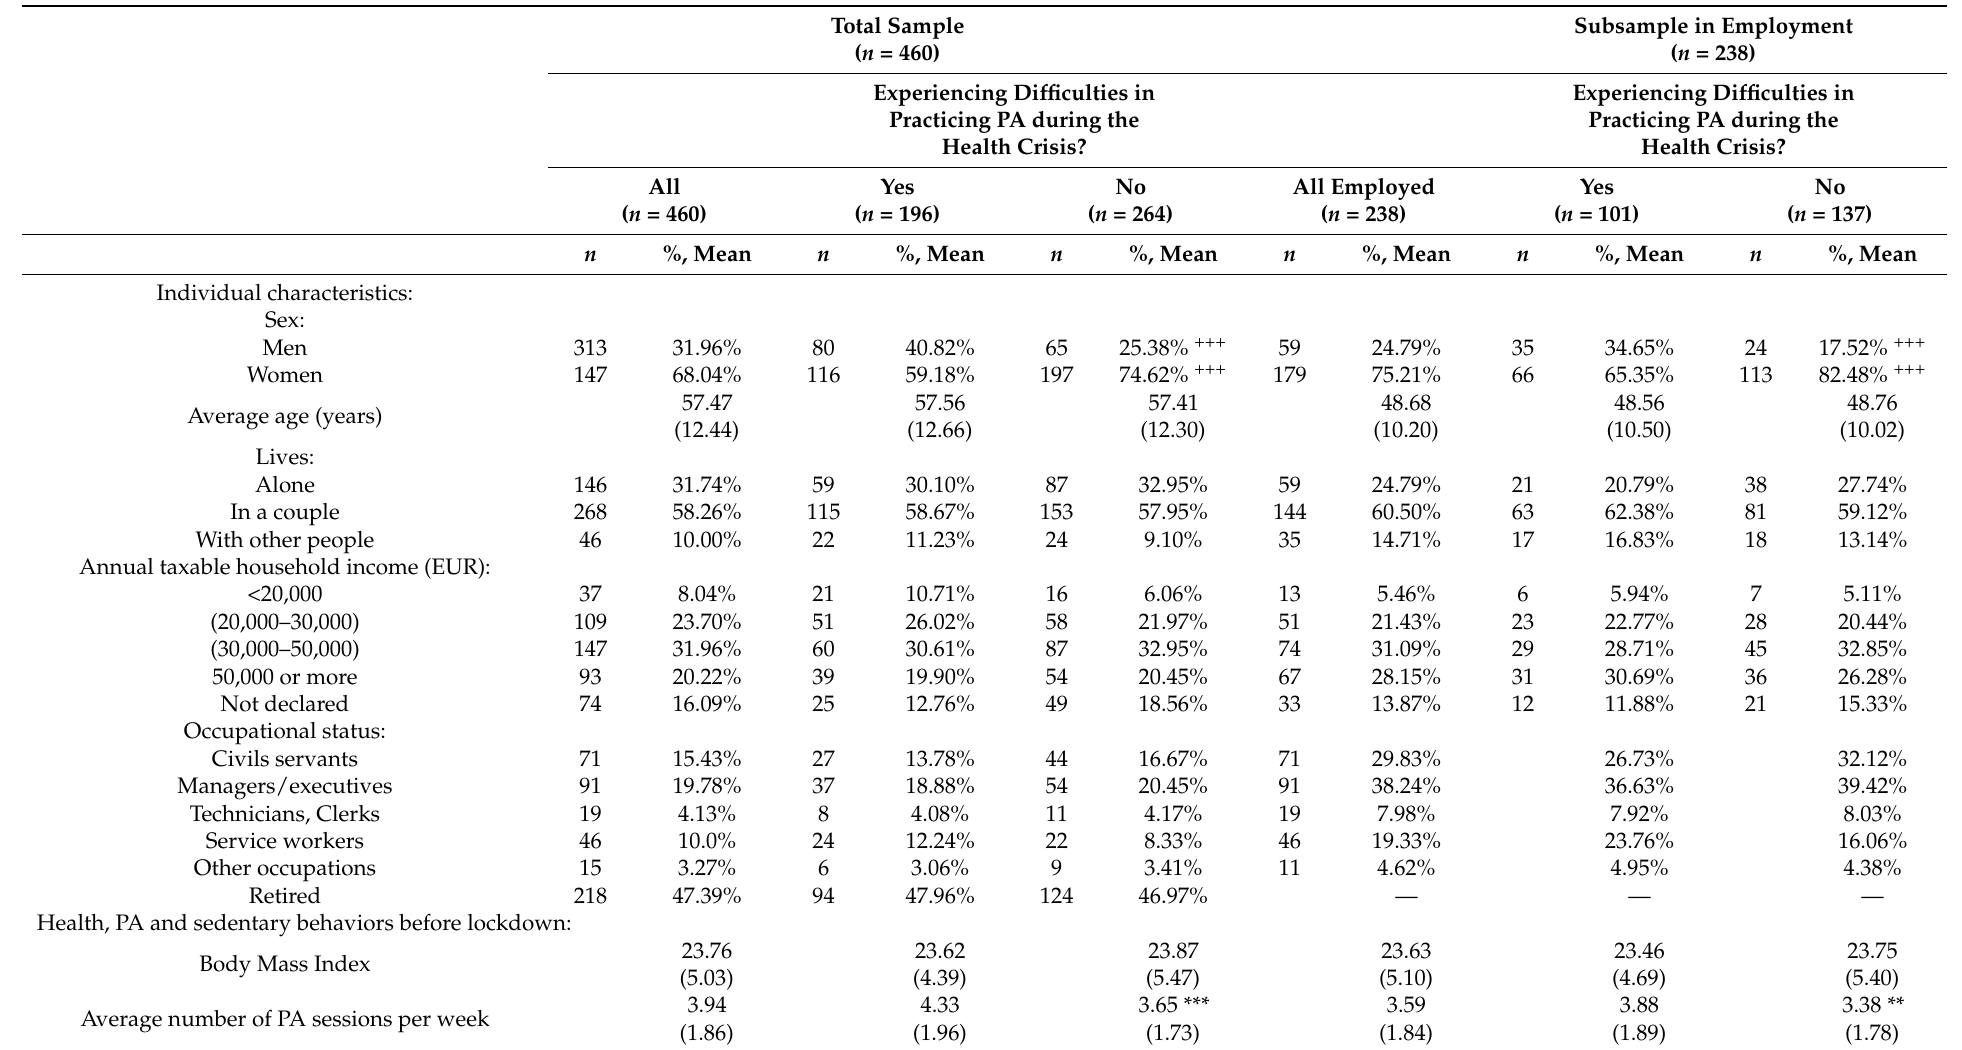
Table 1. Descriptive statistics of the study